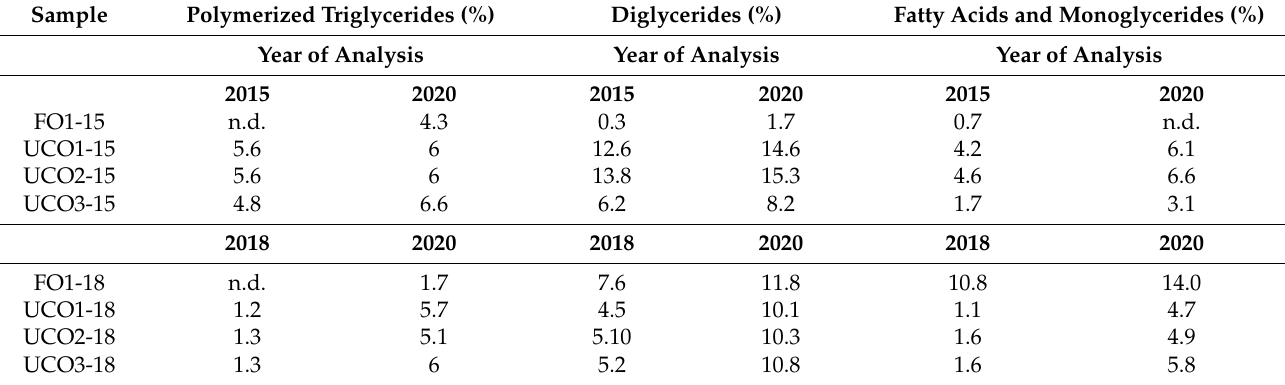
Table 1. Summary of the contents of polymerized triglycerides, diglycerides, and fatty acids and monoglycerides in the bio-oils after different storage times using high-performance size exclusion chromatography (HPSEC). n.d. stands for not detected (detection limit < 0.3%). Sample Polymerized Triglycerides (%) Diglycerides